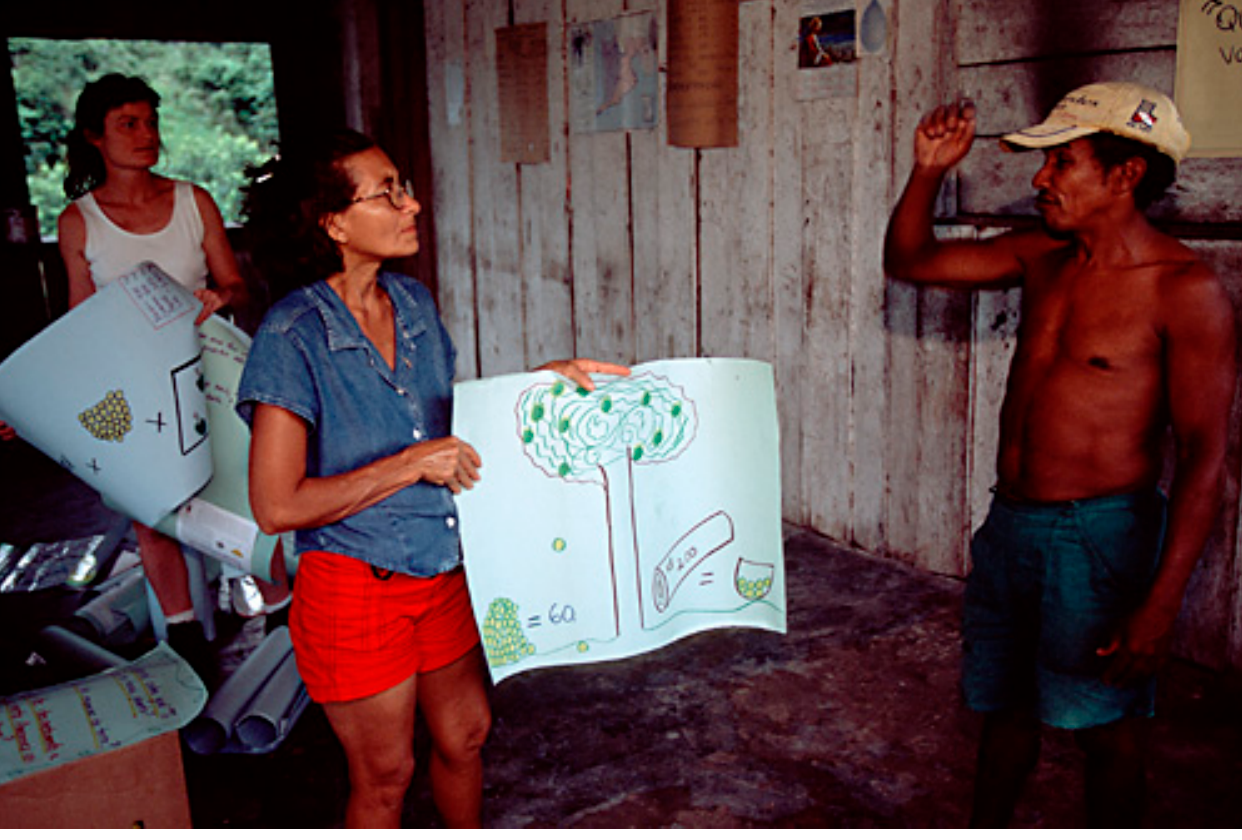
Fig. 5. Gloria and a hunter compare the value of fruit and timber. Photo: Joel